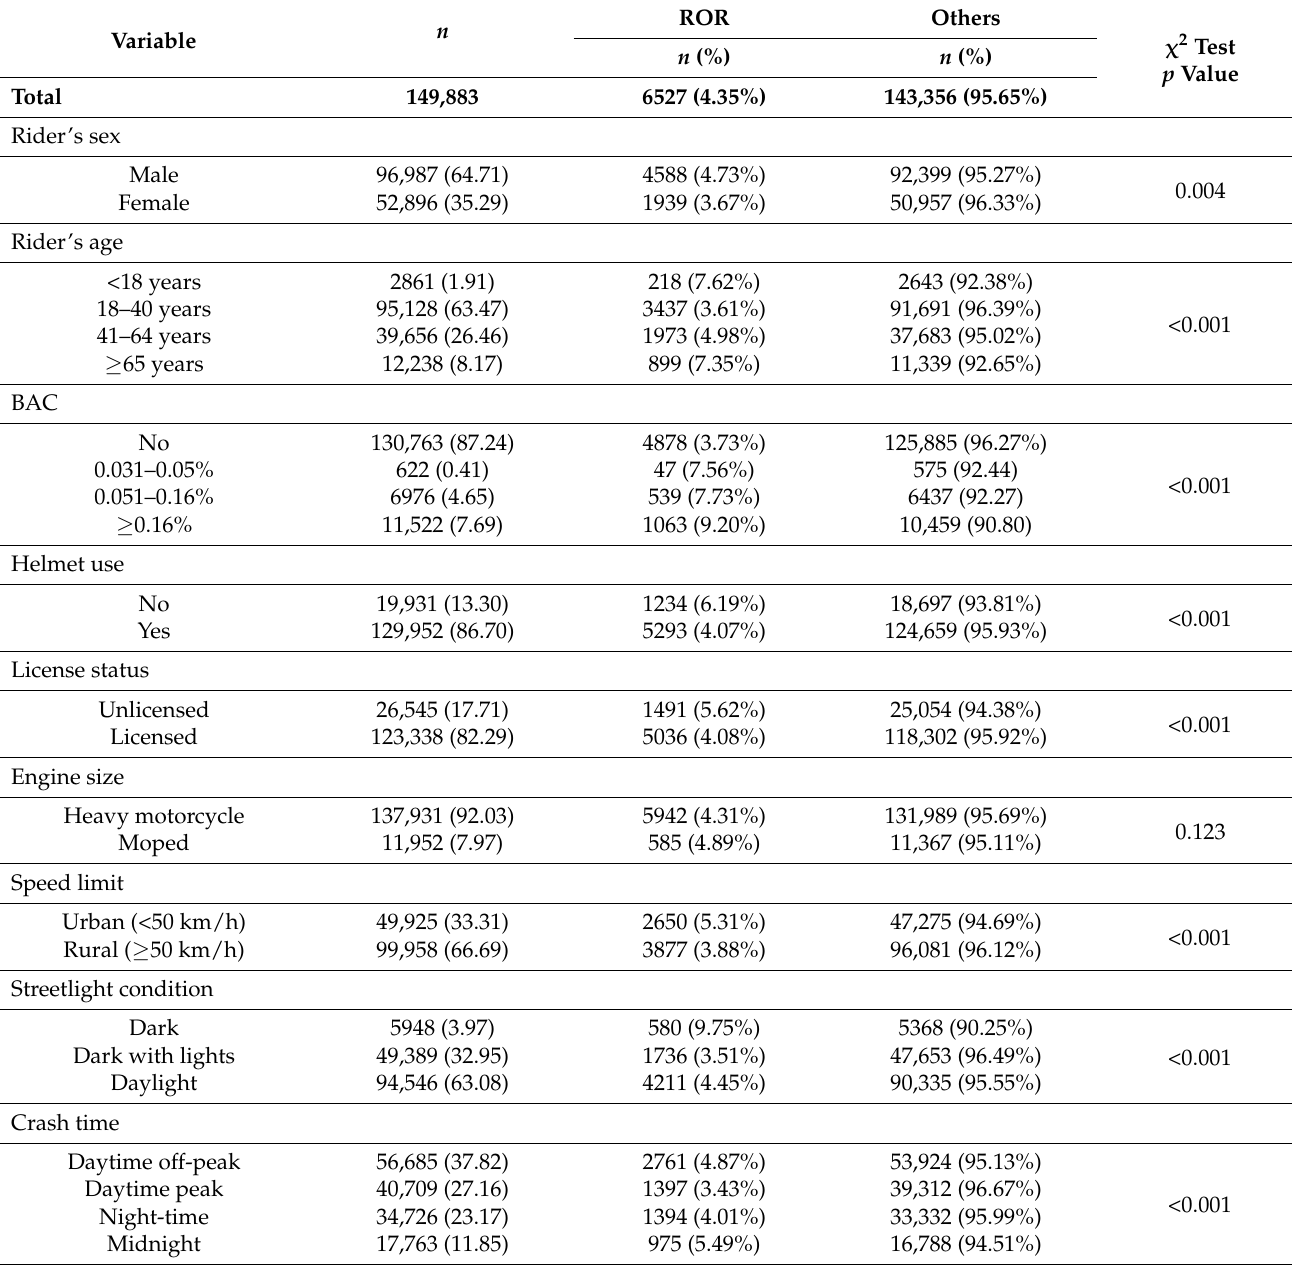
Table 3. Distribution of run-off-road (ROR)